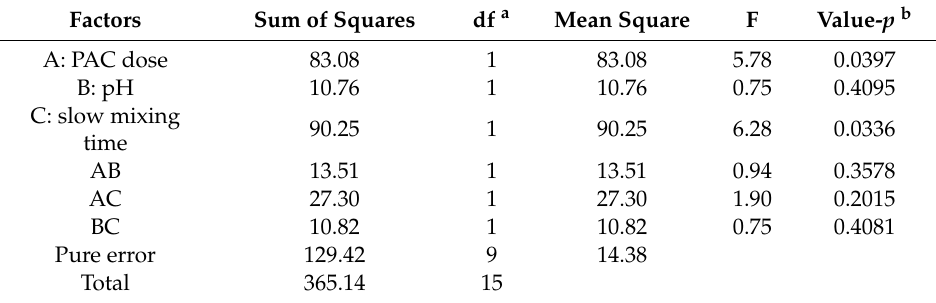
Table 3. ANOVA results for coagulation / sedimentation experiments with PAC